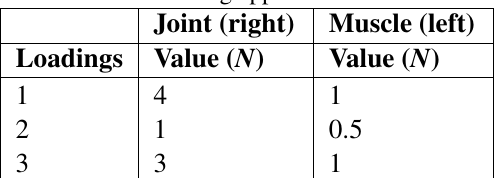
Table 1 Loading applied on the bone Joint (right)